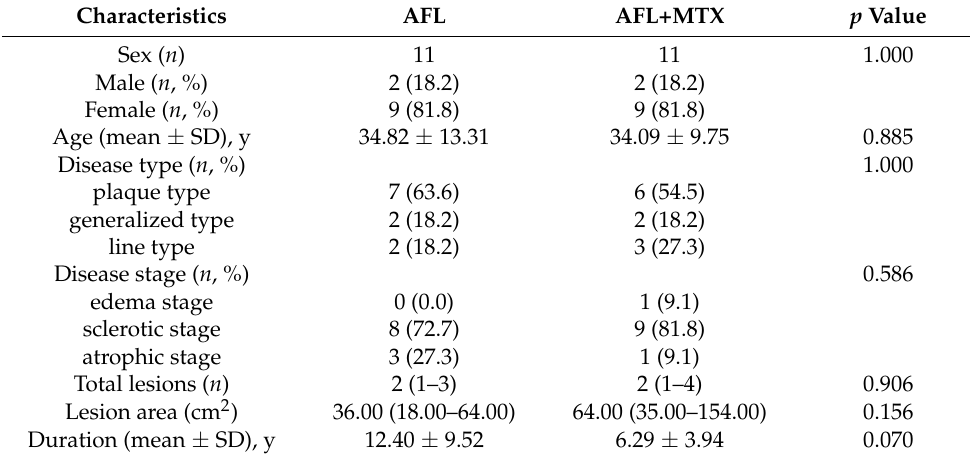
Figure 1. Flow diagram of the clinical trial. AFL group was treated by ablative fractional laser; AFL+MTX group was treated by ablative fractional laser-assisted delivery of methotrexate. Table 1. Characteristics of included patients. The age and the duration of disease are presented as mean ± standard deviation, and the lesion areas of patients are expressed as median and inter-quar- tile range. AFL group was treated by ablative fractional laser and AFL+MTX group was treated by ablative fractional laser-assisted delivery of methotrexate.